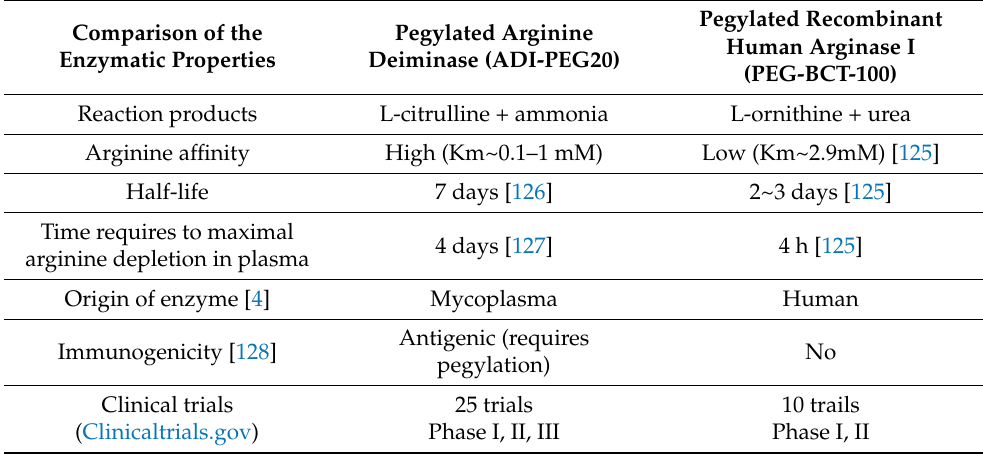
Table 2. Comparison of arginine-depleting